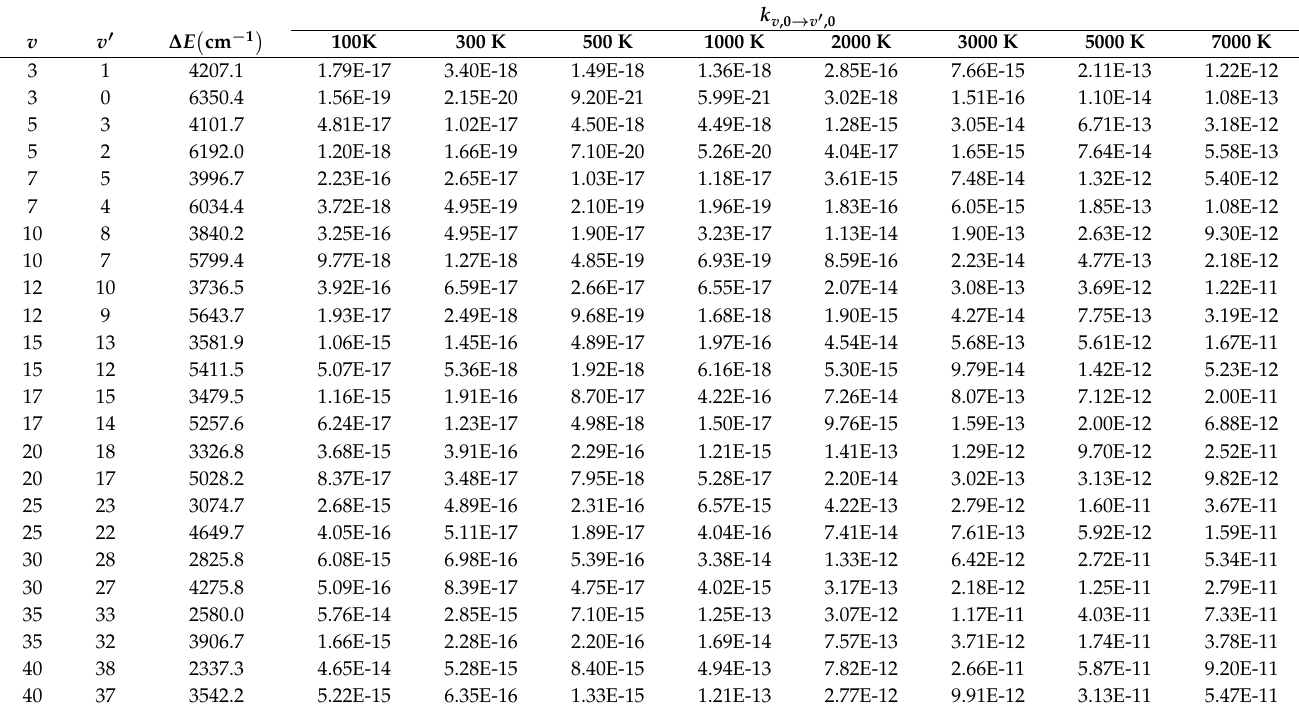
k v ,0 → v (cid:48) ,0